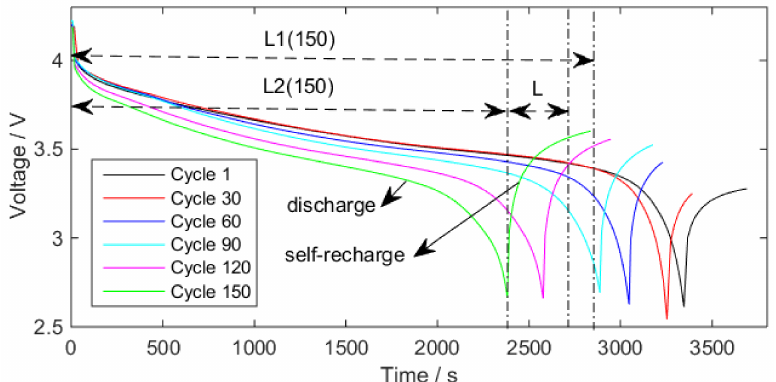
Figure 2. Discharge voltage of battery